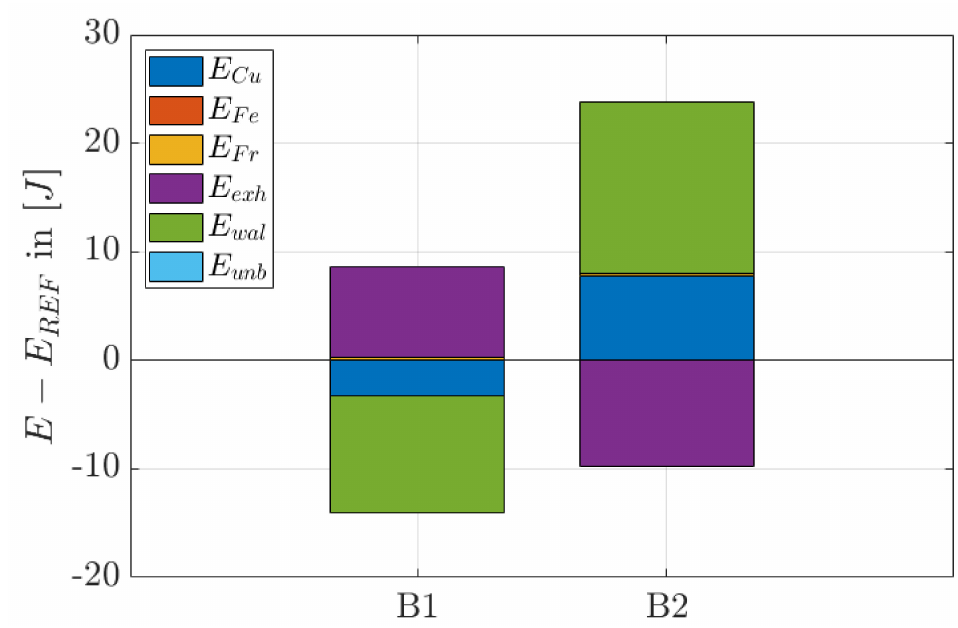
Figure 24. Energy losses for trajectory B1 and B2 with respect to REF.